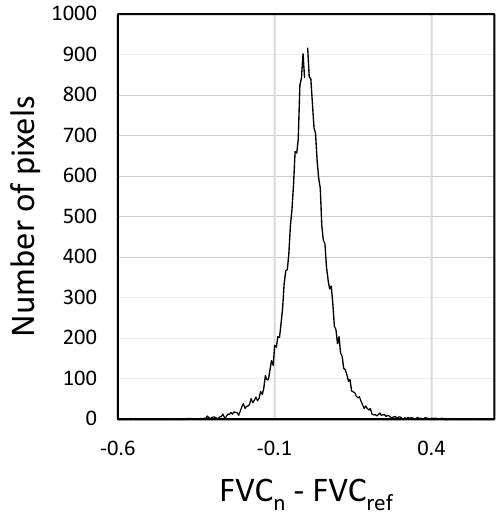
Figure 5. Residue histogram between the FVC values of the component images (FVCn) and those of their mean (FVCref).